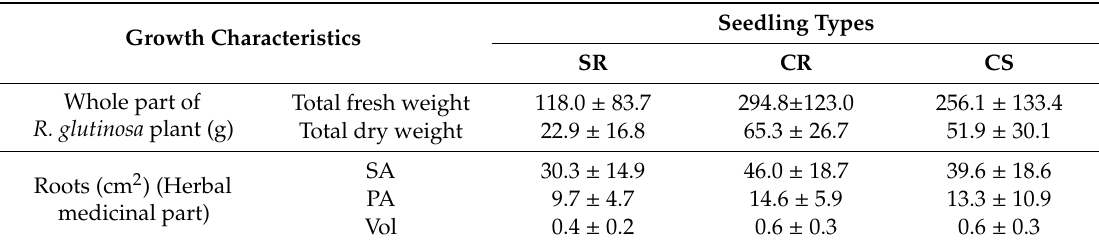
Figure 4. Comparison of the development of the subterranean parts of the three different types of R. glutinosa seedlings (SR, CS, and CR). The indicated statistical differences were calculated using two-way ANOVA and Bonferroni’s post-hoc test: ** p < 0.01. N = 5. Table 2. Comparison of root yields of the different seedling types of R. glutinosa (SR, CR, and CS).